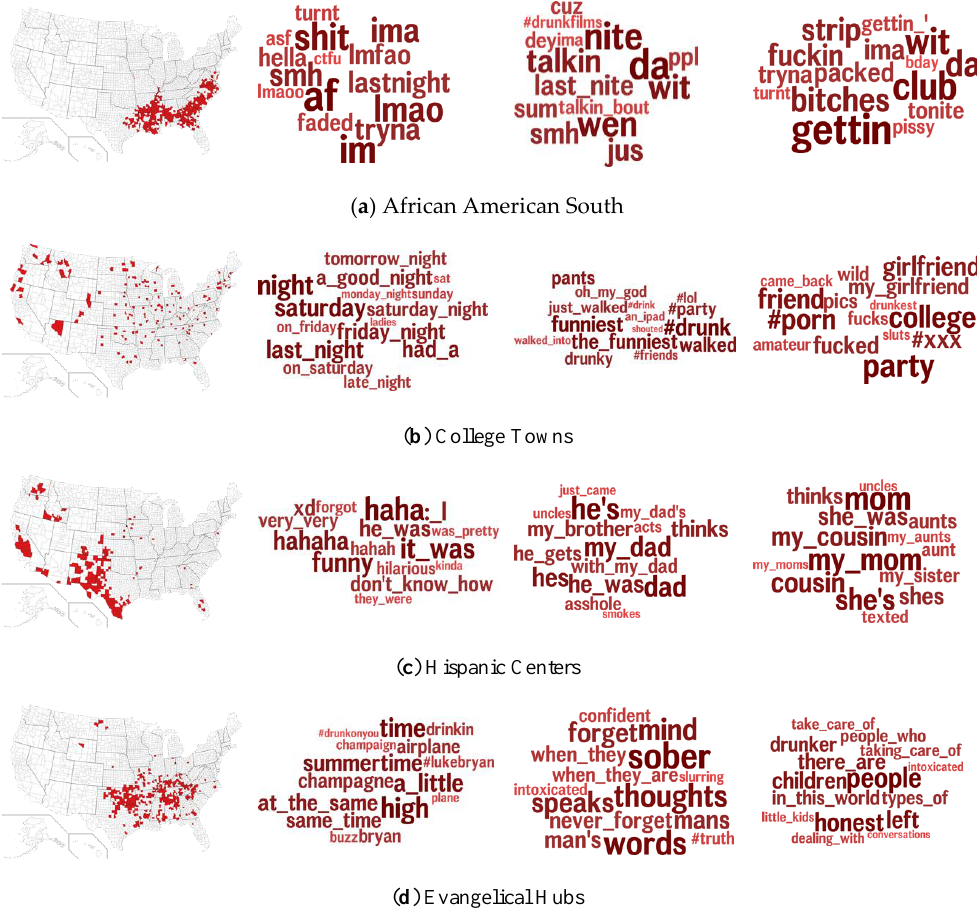
Figure 4. Maps and drunk topics most associated with four ACP communities: ( a ) African American South, ( b ) College Towns, ( c ) Hispanic Centers, and ( d ) Evangelical Hubs. Left most plots indicate the counties (red) within each ACP